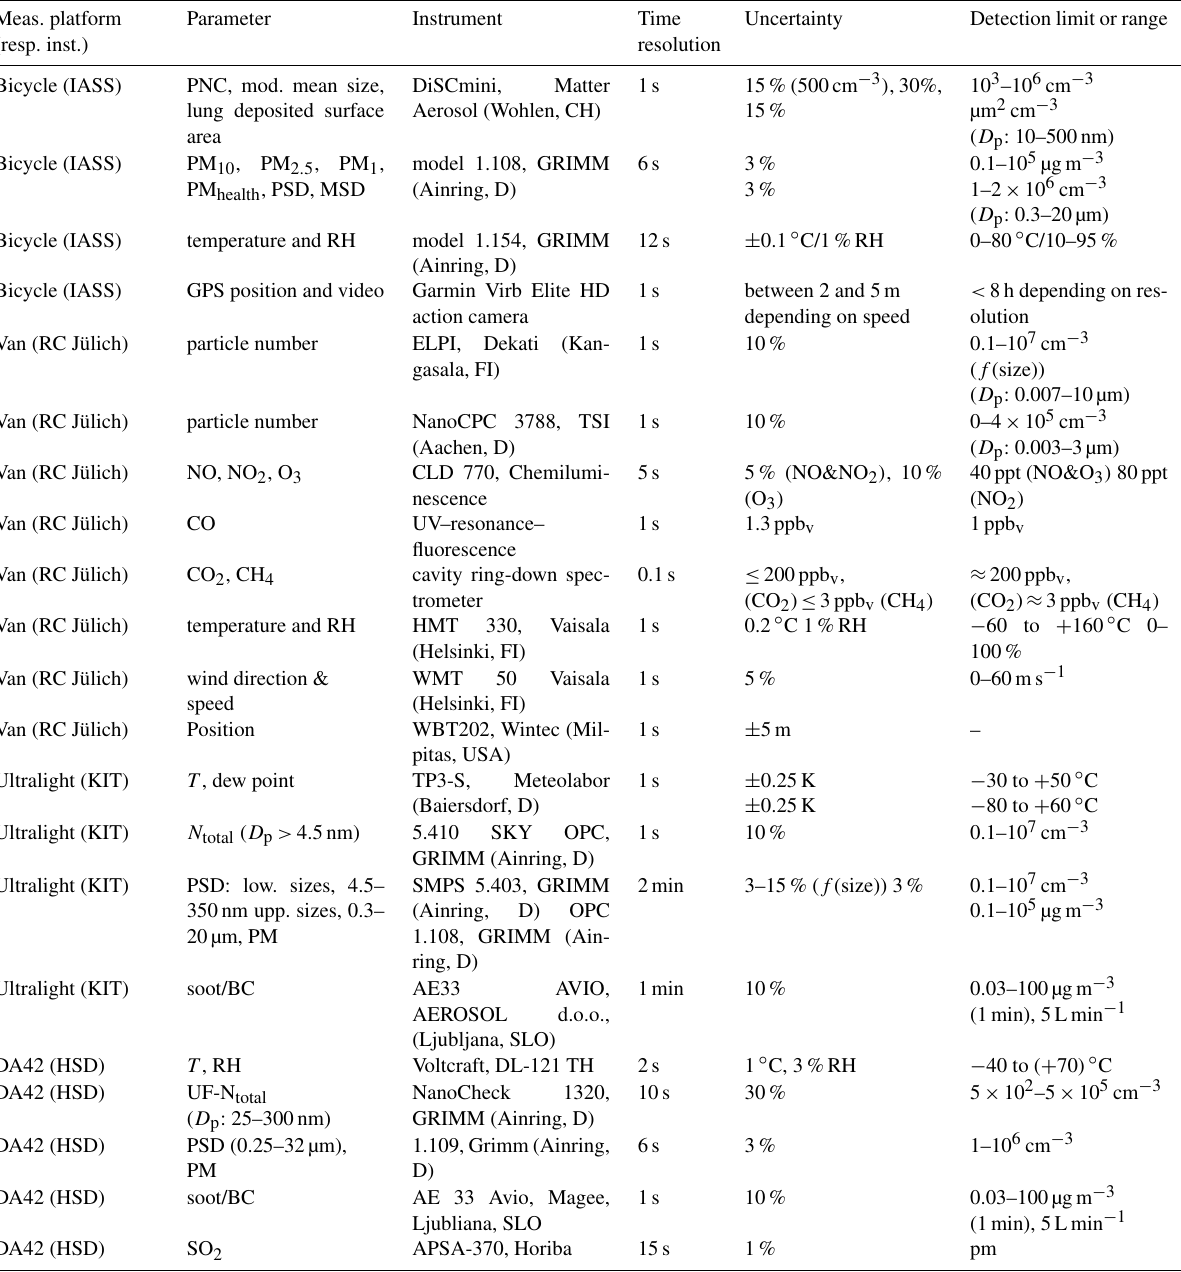
Table A1. List of applied instruments, time resolutions, uncertainties and detection limits/ranges. Meas. platform (resp.